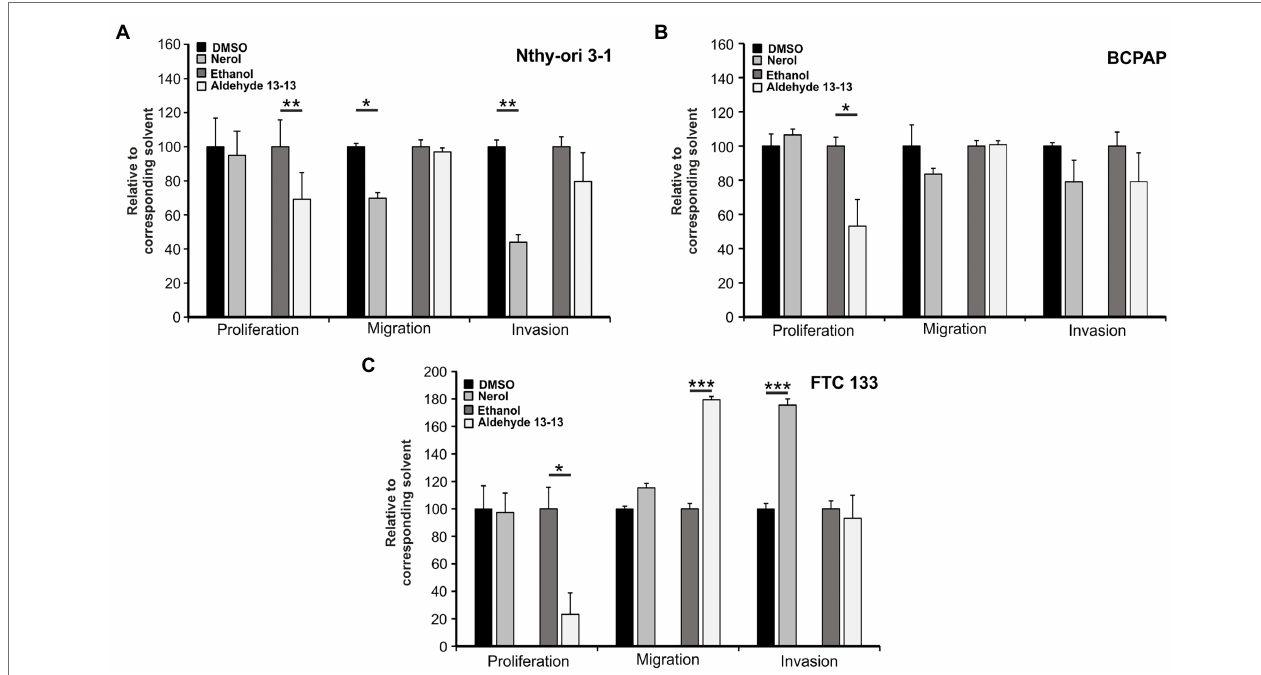
FIGURE 5 | Nerol and aldehyde 13-13 influence migration, invasion, and proliferation of Nthy-ori 3-1 (A) , BCPAP (B) , and FTC 133 (C) cells. Transwell proliferation of the three cell lines treated with nerol or aldehyde 13-13 (500 μ M; n = 5 in triplicates). In the transwell migration assay, the cells were stimulated with nerol or aldehyde 13-13 with a concentration of 250 μ M ( n = 3–4 in triplicates). In the transwell invasion assay, the Nthy-ori 3-1, BCPAP, and FTC 133 cells were treated with either nerol or aldehyde 13-13 (250 µM; n = 4 in triplicates). The percentage of cell migration, invasion, or proliferation of cells/well normalized to the respective solvent control is shown. For all results, the mean values are shown with the corresponding SEM. Data significance was calculated by comparing solvent controls with odorant-treated cells using student’s paired t -test. The comparison was made only within cell lines. * p ≤ 0.05, and ** p ≤ 0.01, and *** p ≤